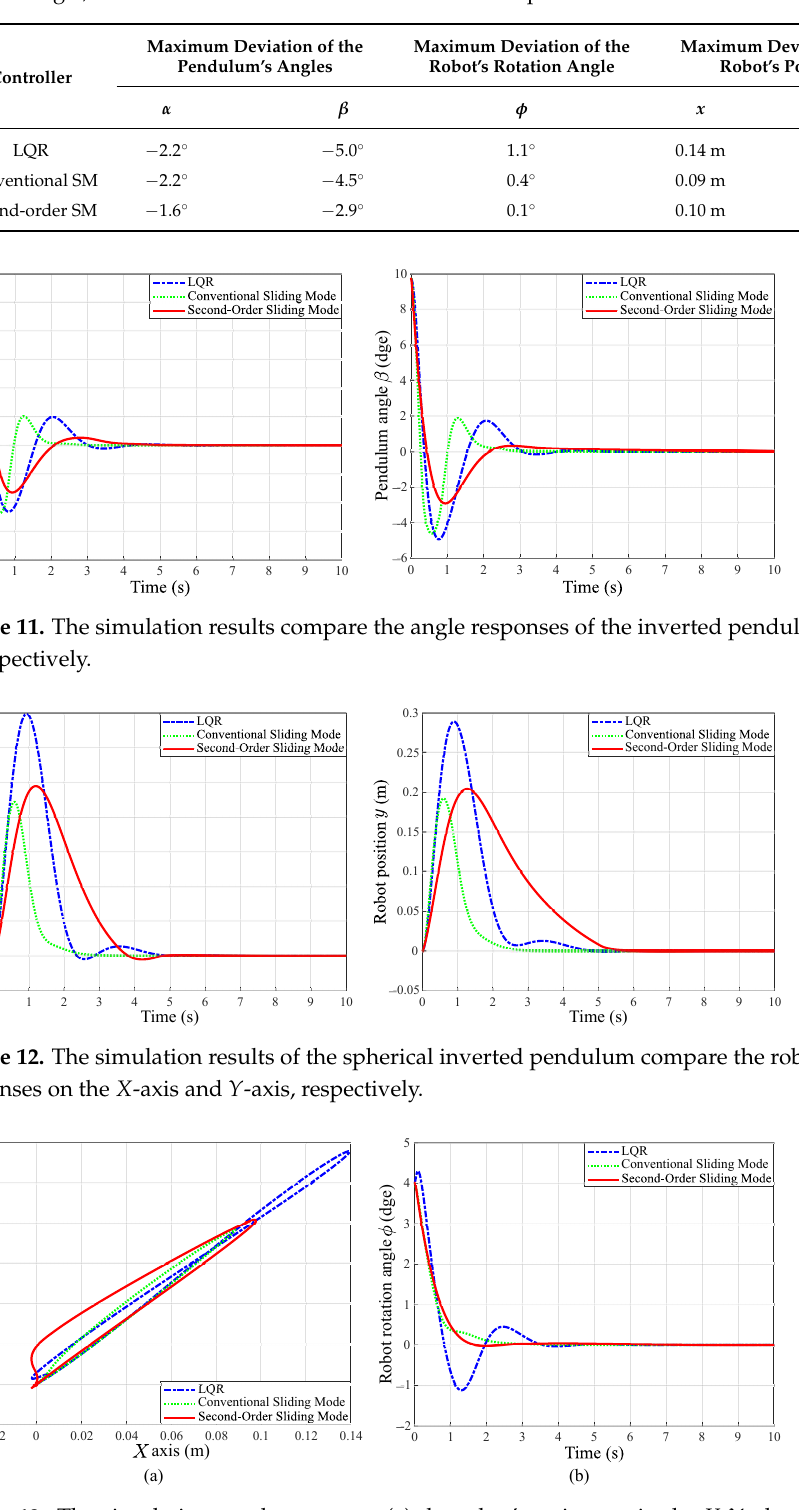
Figure 13. The simulation results compare ( a ) the robot’s trajectory in the X - Y plane and ( b ) the rotation angle responses of the